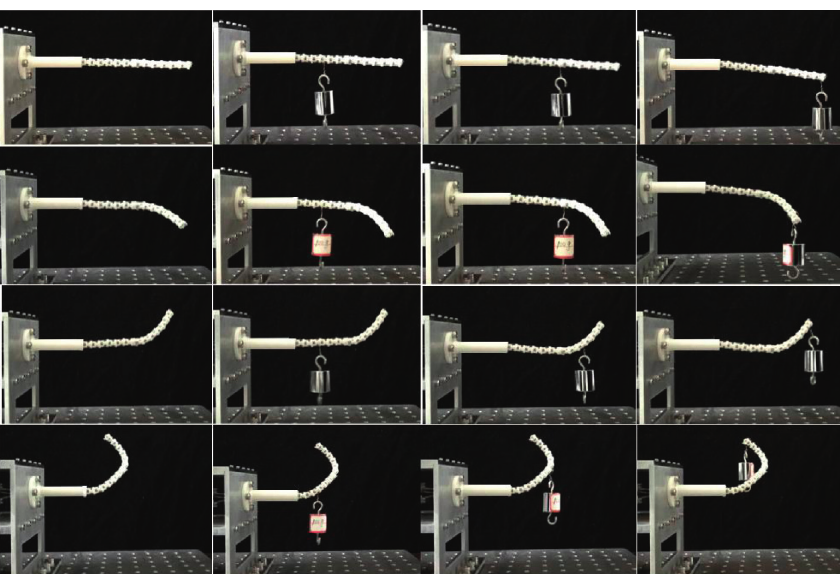
Figure 17: The 1N payload experiments in the different positions of the